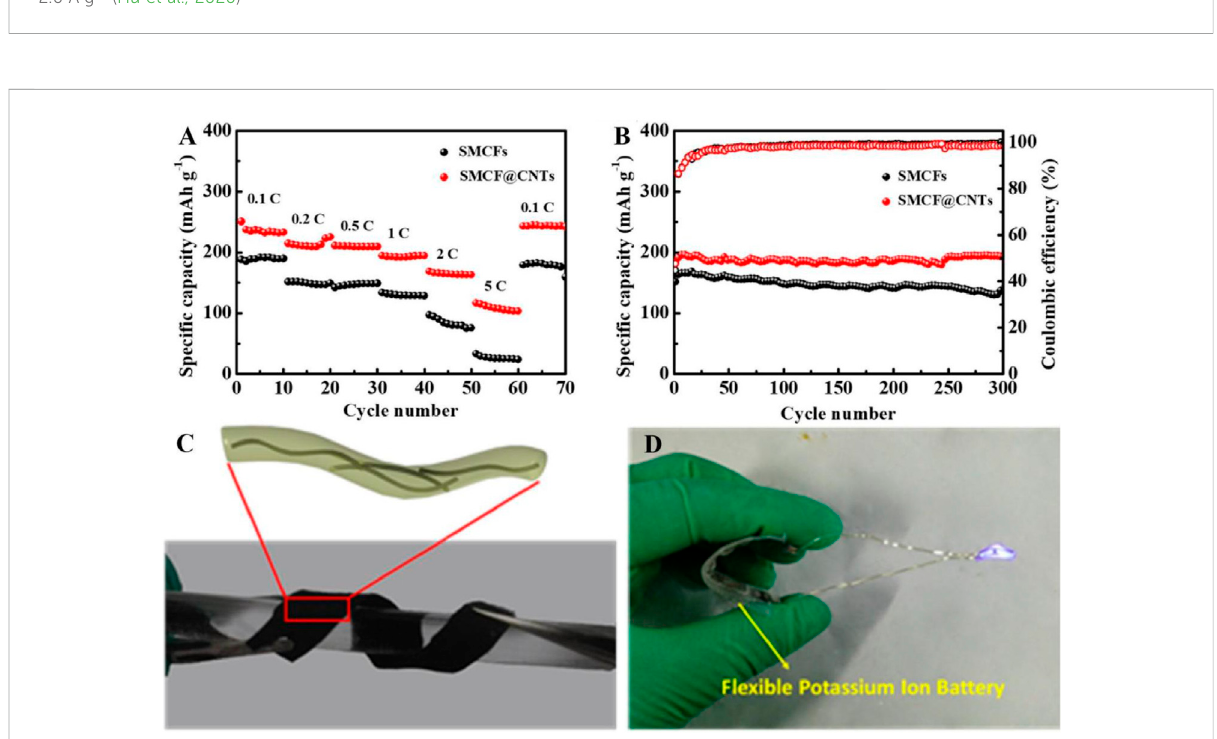
FIGURE 4 (A) Rate performance of SMCFs and SMCF@CNTs from 0.1 to 5 C (1 C = 279 mA g − 1 ). (B) Cycling performance of SMCFs and SMCF@CNTs at a current rate of 1 C. (C) Digital photo illustrating the fl exibility of SMCF@CNTs. (D) LED lit by the SMCF@CNT/K 0.3 MnO 2 pouch cell under bending (Shen et al.,